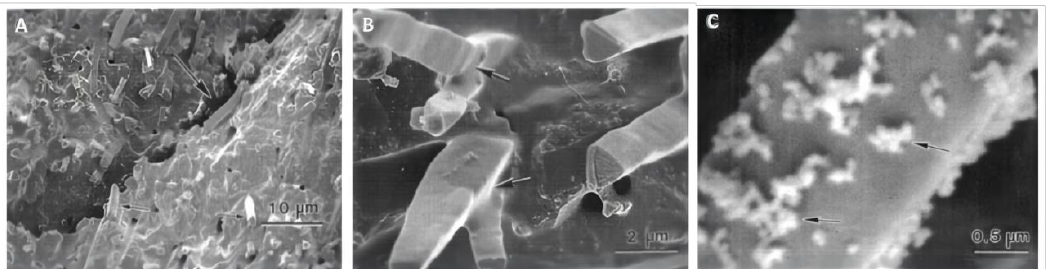
Figure 3. SEM micrographs of the fracture surfaces of the whisker composite at different ratios of whiskers to silica. ( A ) The composites containing silica-fused whiskers showed rougher fracture surfaces, with large fracture steps (large arrows) and pulled-out whiskers (small arrows). ( B ) The whiskers appeared to be well bonded with the matrix resin at whisker-resin interfaces, as indicated by the arrows. ( C ) The silica particles on the surface of the whiskers. Images from [68].